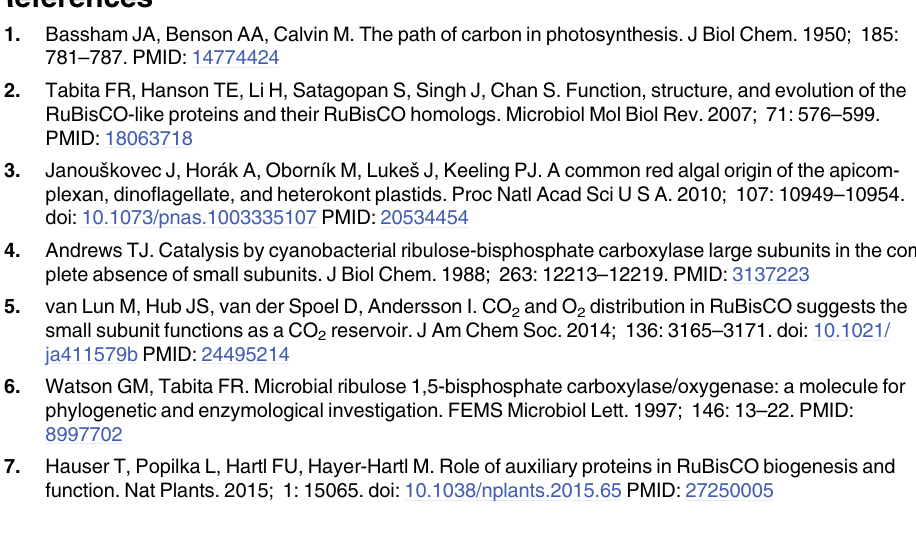
S3 Fig. Phylogenetic tree of RCA protein sequences. (PDF) S4 Fig. GroEL/GroES homologs in E . longa . (PDF) S1 Table. List of PCR and qPCR primers used in this work. (PDF) S2 Table. List of the RBCL sequences used in phylogenetic analysis. (PDF) S3 Table. List of the RBCS sequences used in phylogenetic analysis. (PDF) S4 Table. List of the RCA sequences used in phylogenetic